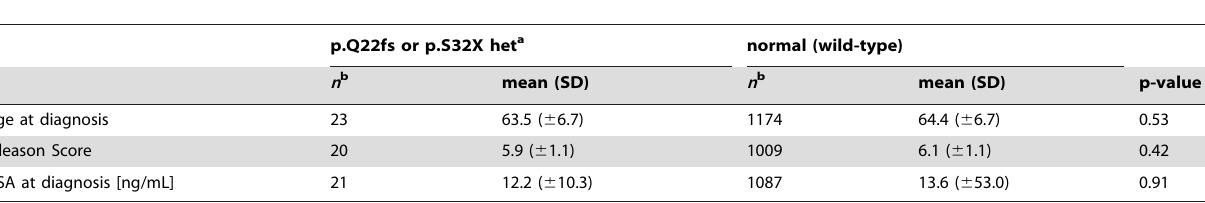
Table 2. Comparison of age at diagnosis, Gleason Score and PSA at diagnosis between carriers of the truncating TP53AIP1 variants and